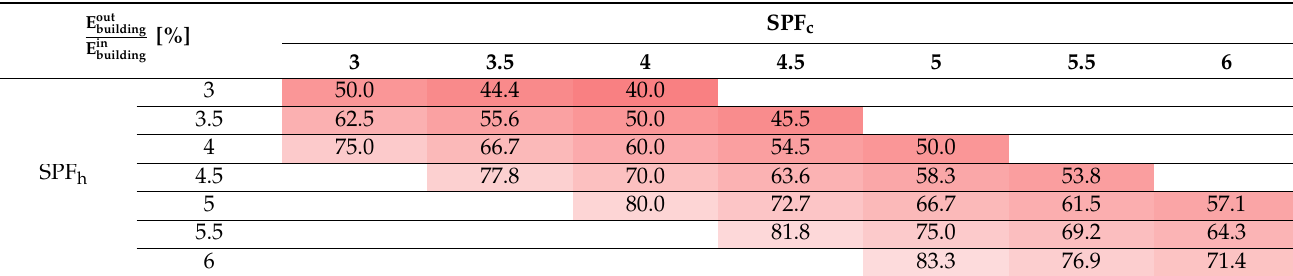
Table 2. Ratio of cooling demand with respect to heating demand (E out a balanced heat exchange with the ground (E out SPF c and SPF h . Cells corresponding to more pronounced heating-dominated demands show a more intense red